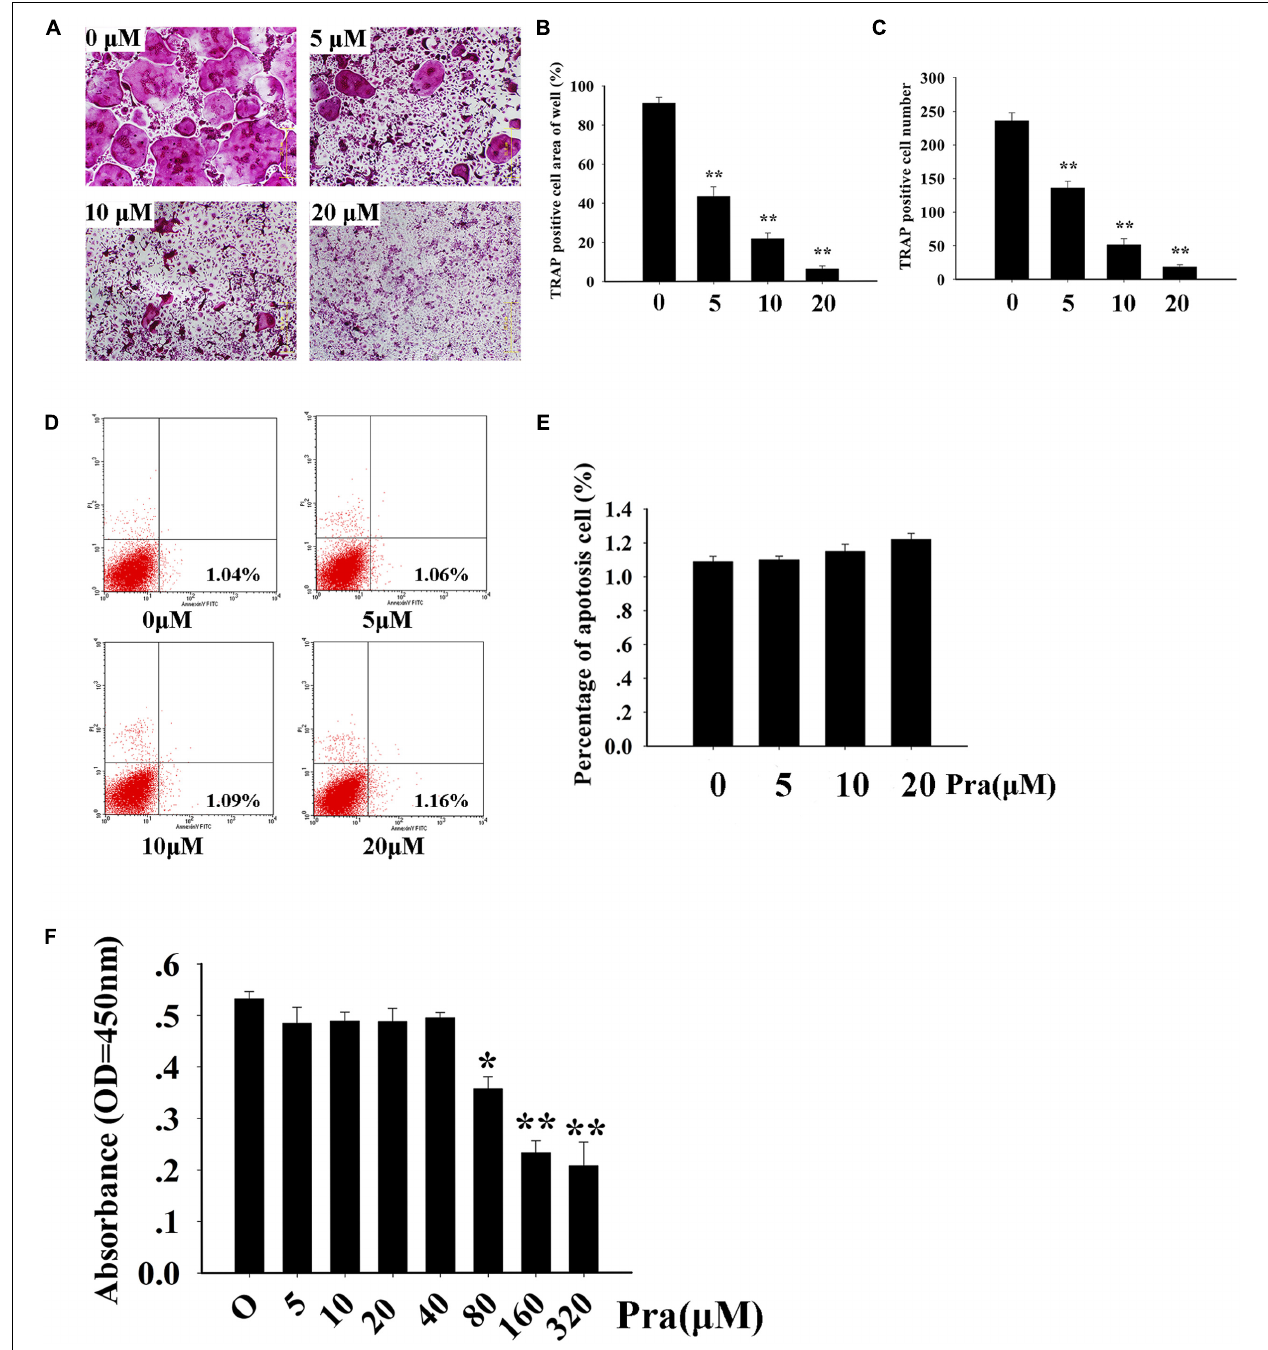
FIGURE 1 | Praeruptorin C (Pra-C) inhibits osteoclast formation without cytotoxic and apoptotic effects. (A) Bone marrow-derived macrophages (BMMs) were treated with different concentrations of Pra-C (0, 5, 10, or 20 µ M), followed by 30 ng/mL M-CSF and 50 ng/mL RANKL for 5–7 days. Then, cells were fixed with 4% paraformaldehyde and subjected to tartrate-resistant acid phosphatase (TRAP) staining. (B) Quantification of the area of TRAP+ cells. (C) Quantification of the number of TRAP+ cells. (D) BMMs were seeded in six-well plates and treated with different concentrations of Pra-C (0, 5, 10, or 20 µ M) for another 48 h, and then subjected to staining with Annexin V-APC and propidium iodide. Cells were analyzed by flow cytometry. (E) Quantification of the cell apoptosis rate by flow cytometry. (F) BMMs were cultured in a 96-well plate and treated with 30 ng/mL M-CSF, and different concentrations of Pra-C, for 48 h. Cell viability was measured by CCK-8 assay. All plotted data are the means ± SD ( n = 3). ∗ P < 0.05; ∗∗ P < 0.01, versus 0 µ M Pra-C.